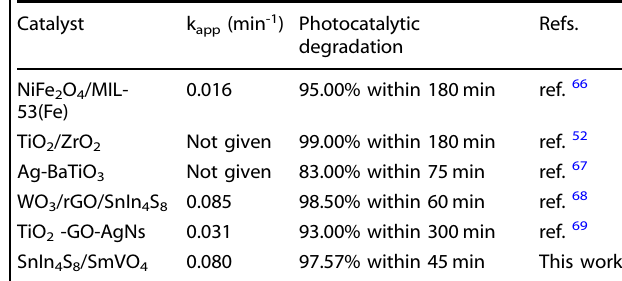
Table 3. Photocatalytic RhB reduction over various photocatalysts under visible light irradiation.